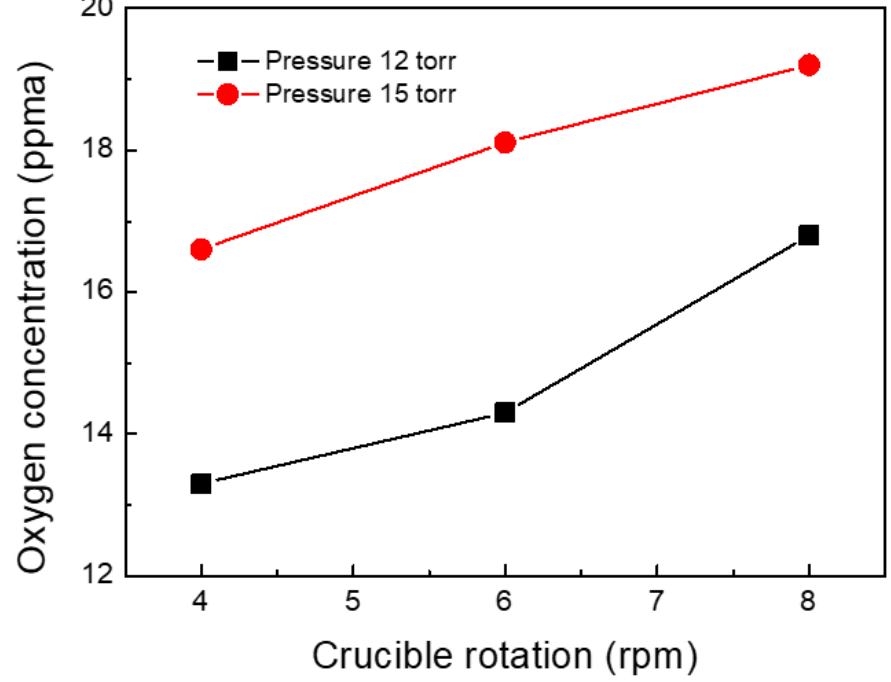
Figure 3. Relationship between initial oxygen content, furnace pressure, and crucible rotation.